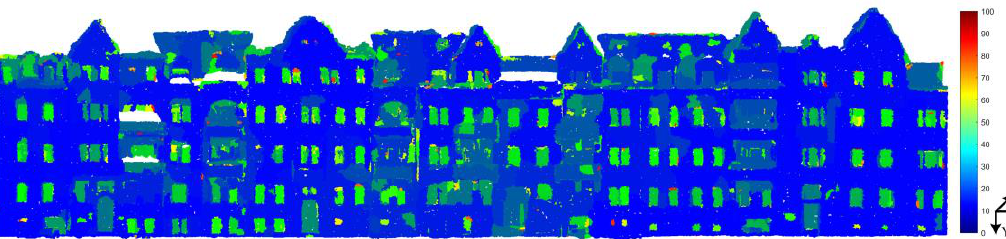
Figure 4. Energy optimization result